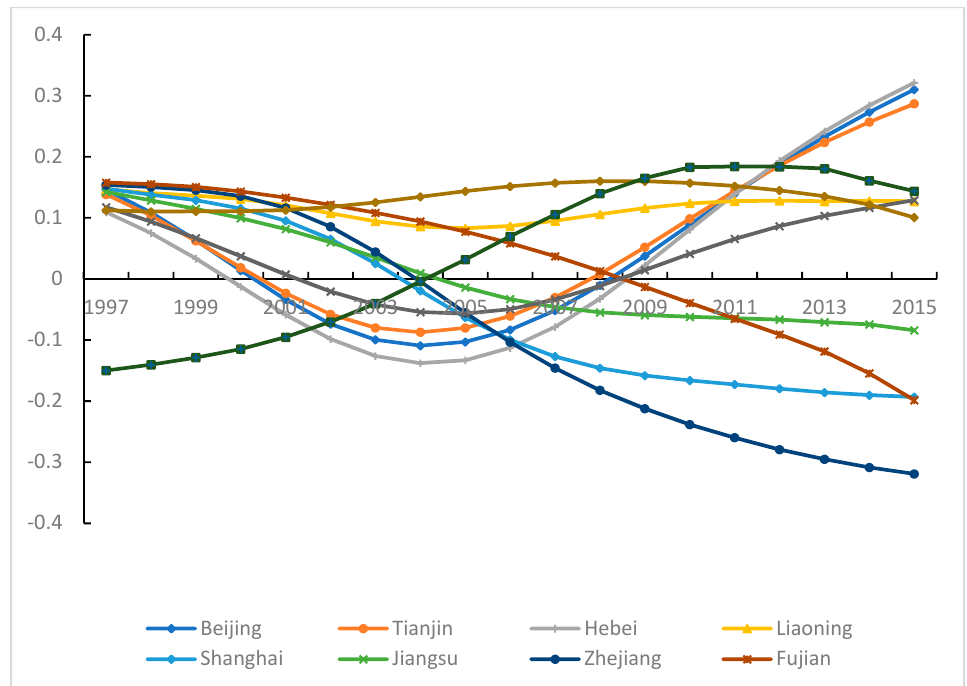
Figure 9. Parameter estimates of industrial pollution emissions in Eastern China.